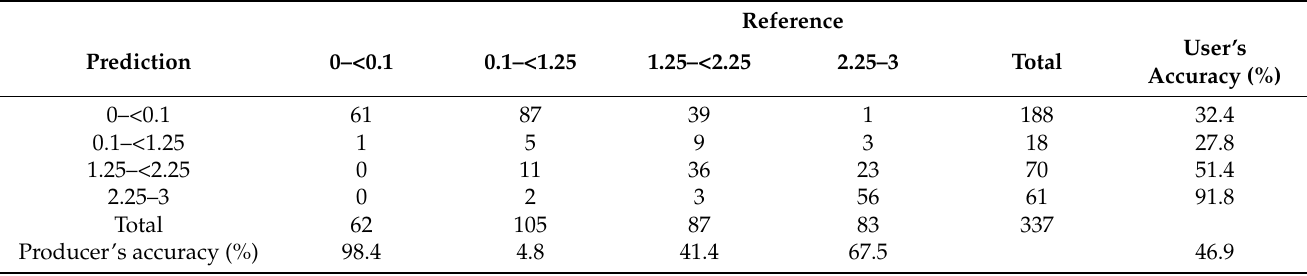
Table A10. Confusion matrix for current RAVG (Miller et al., 2009) model predicting IA CBI with Landsat RdNBR with offset.